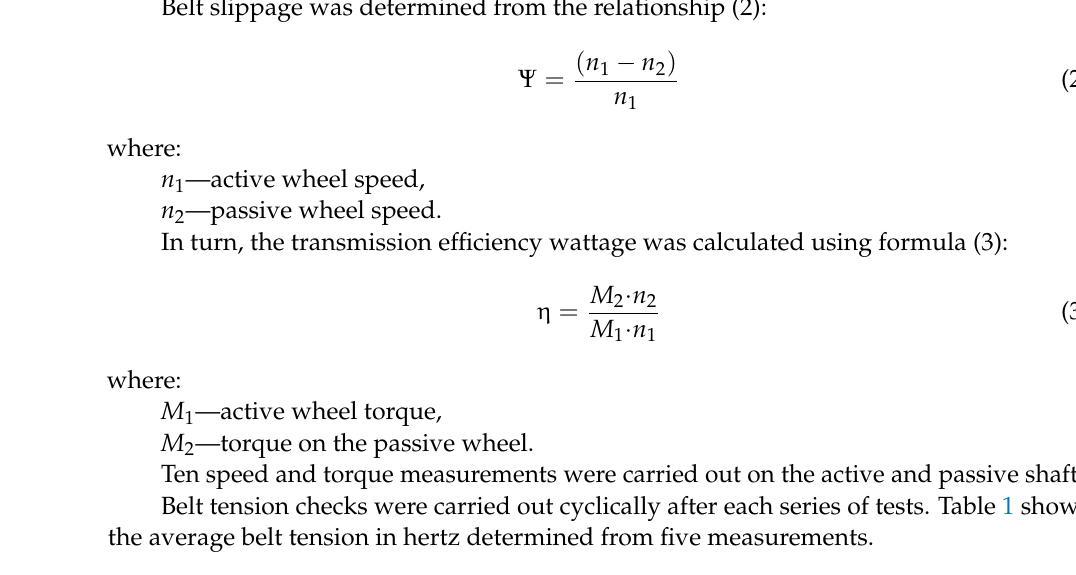
Table 1. Belt vibration frequency values with correct belt tension. Belt Vibration Frequency